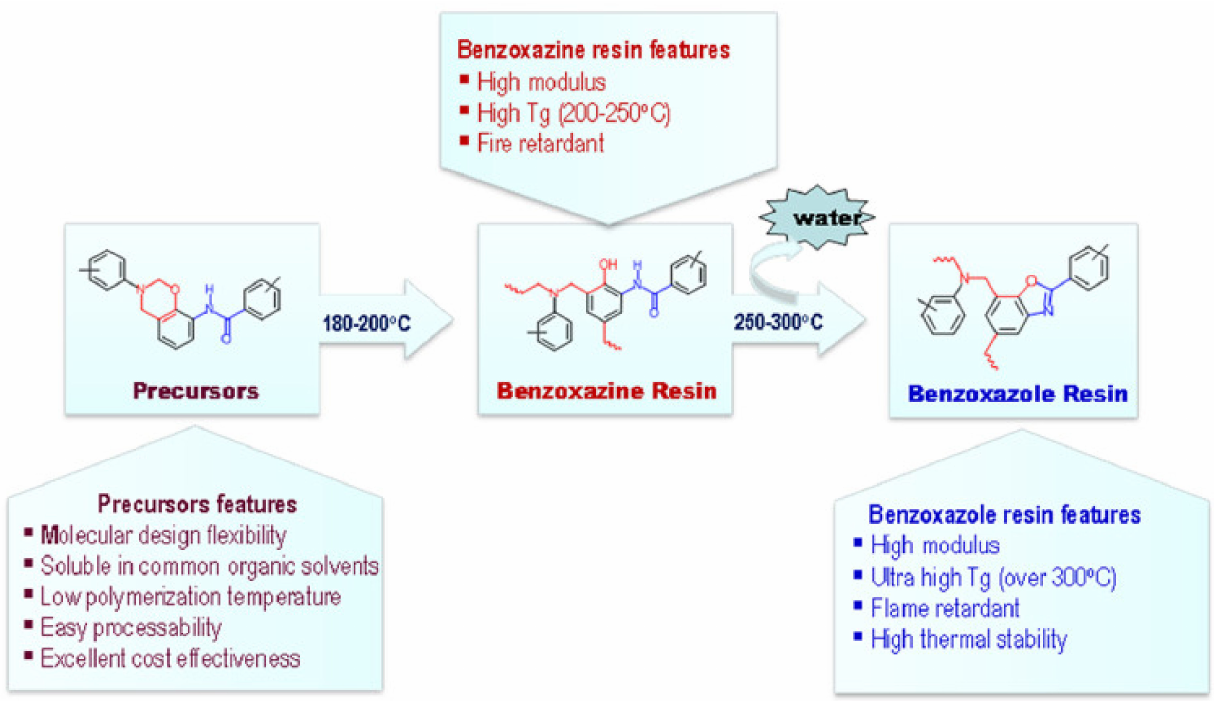
Figure 15. Smart features for easy synthesis of benzoxazole resin via o − amide functional benzoxazine monomer [193]. Copyright 2012. Reproduced with permission from American Chemical